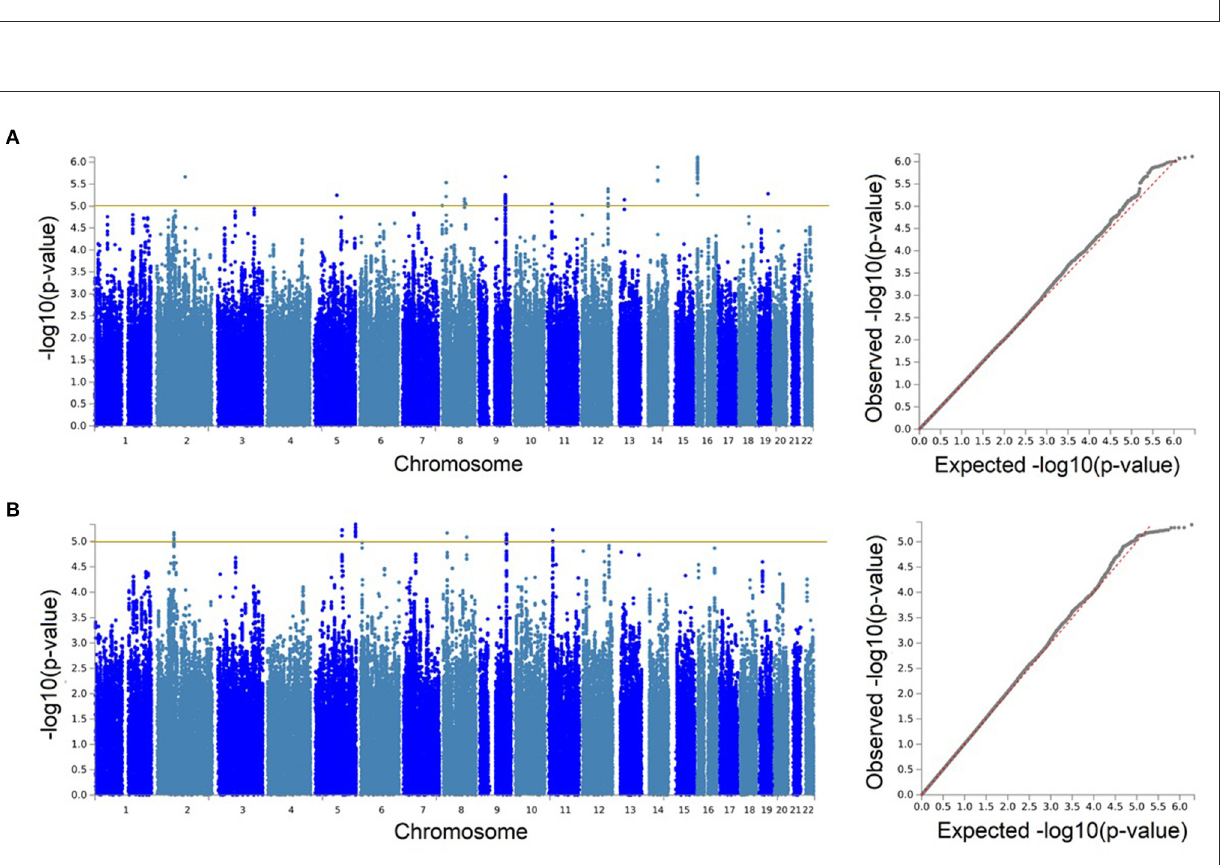
FIGURE2 Genetic associations with serum neurofilament light chain were only identified at the suggestive level. Manhattan and quantile-quantile (QQ) plots for the discovery genome-wide association study in BiDirect ( N = 1,899) (A) , and its meta-analysis with ASPS-Fam ( N = 2,186) (B) . Yellow lines in the Manhattan plots mark the suggestive threshold for genome-wide significance ( p < 1 × 10 − 5 ).